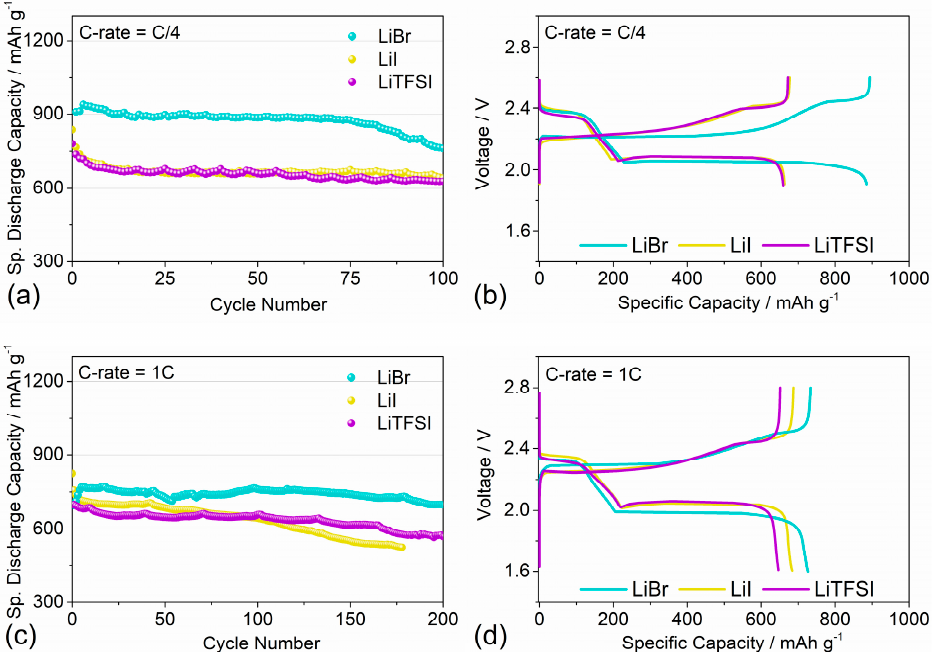
Figure 5. ( a , c ) Galvanostatic cycling performance and ( b , d ) the relative voltage profiles of LSBs realized with LiBr, LiI, and LiTFSI electrolytes performed in a 1.6–2.8 V voltage range carried out at ( a , b ) C/4 = 419 mA g − 1 and ( c , d ) 1C = 1675 mA g − 1 . The voltage profiles were plotted considering the 50th cycle.